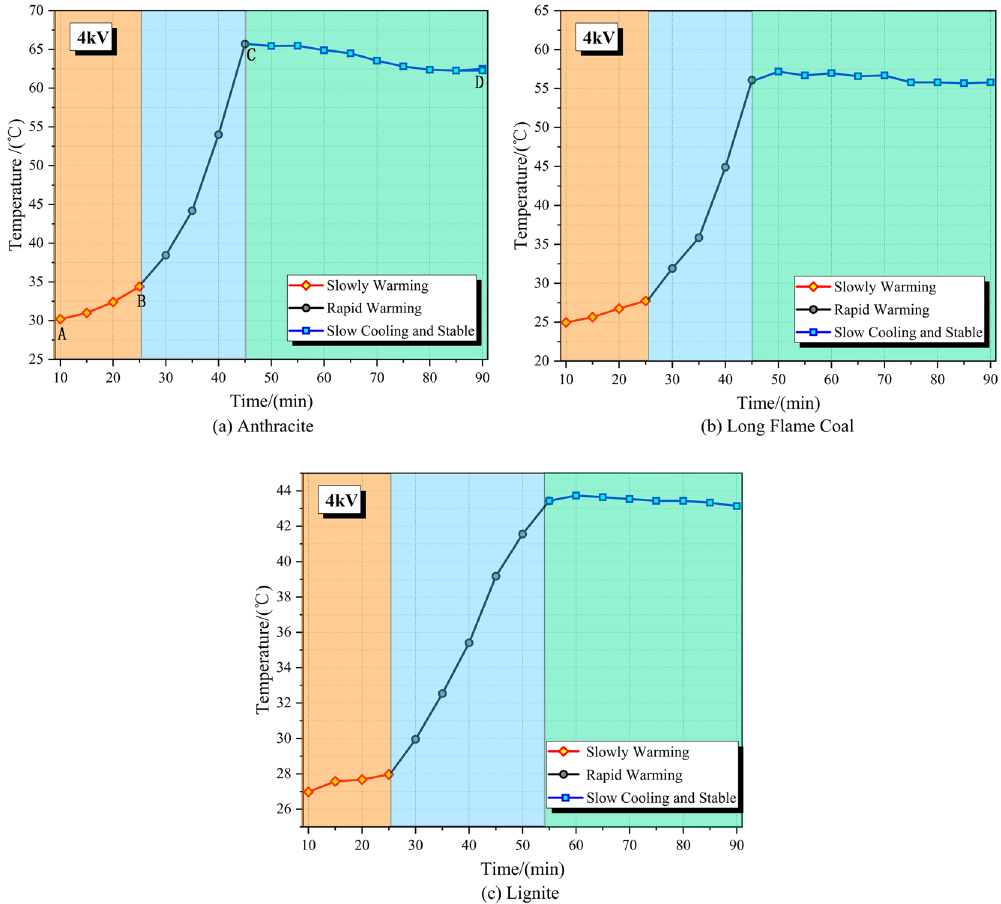
Figure 4. Variation curve of surface temperature of coal with different metamorphic degree under 4